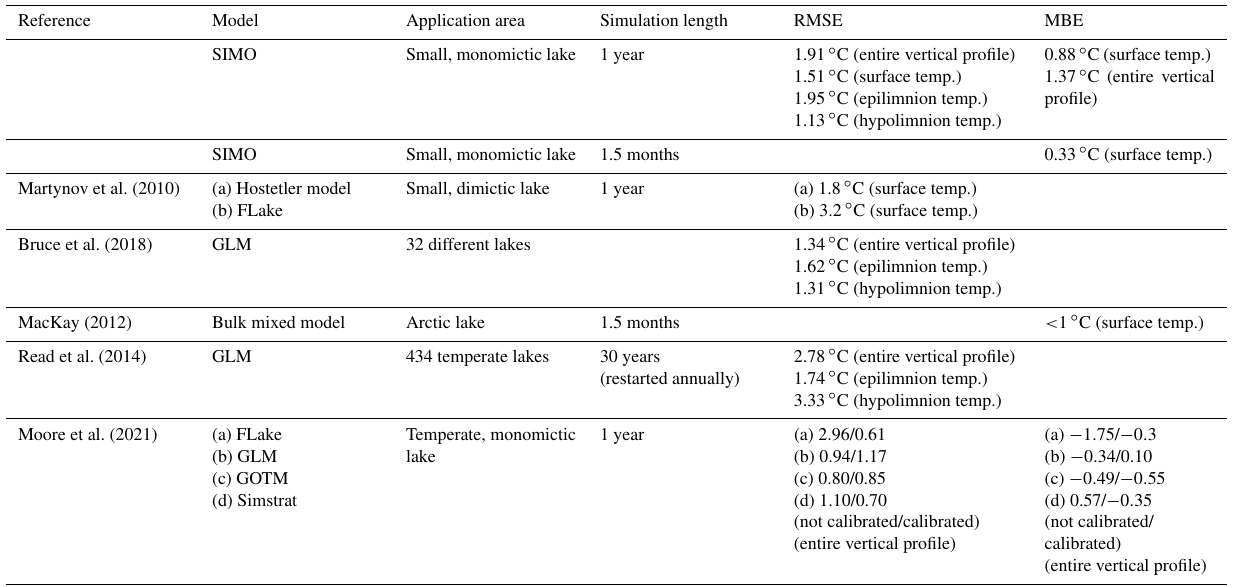
Table 4. Comparison of SIMO performance with other